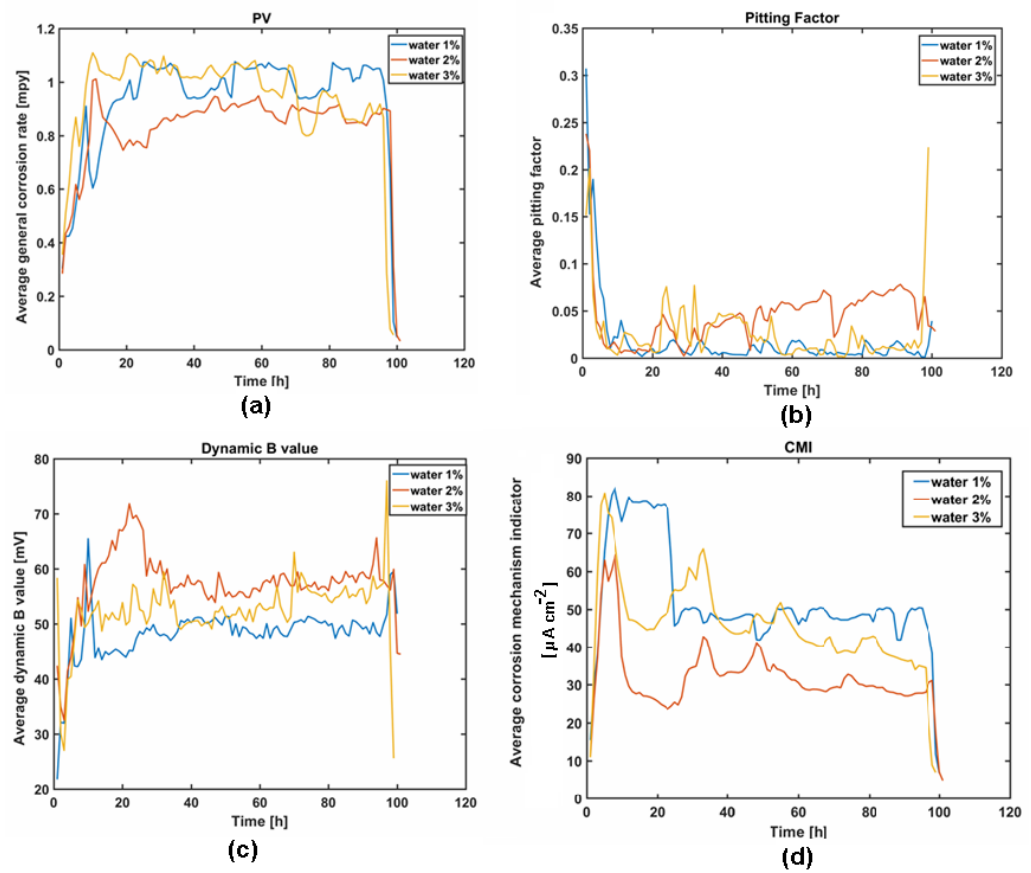
Figure 3. General corrosion rate ( a ), pitting factor ( b ), dynamic B value ( c ), and corrosion mechanism indicator ( d ) measured in sulfolane solutions with the addition of 1, 2, and 3 vol.% of water at 95 °C.